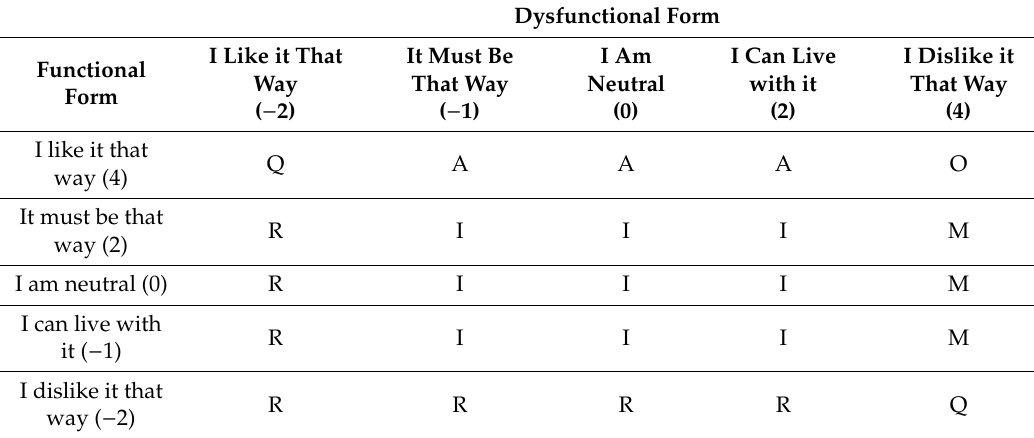
Table 5. Kano Evaluation